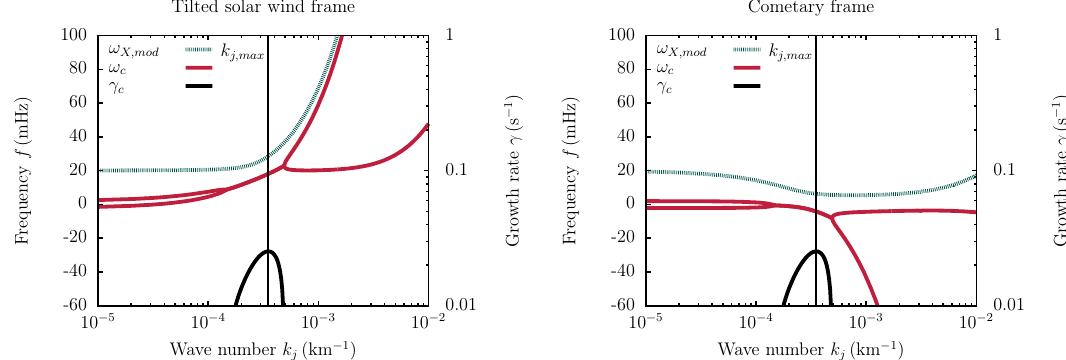
Figure 4. Wave propagation parallel to the cometary current j analogous to Fig. 3. A maximum of the growth rate γ c (black) is found at c wave number k j, max ≈ 3 . 5 × 10 − 4 km − 1 (λ max ≈ 18000km ) with finite frequencies in the water ion branches (red). While the frequency is positive in TSW (left), the wave propagates in opposite direction due to the Doppler shift in the cometary rest frame (right) resulting in a negative